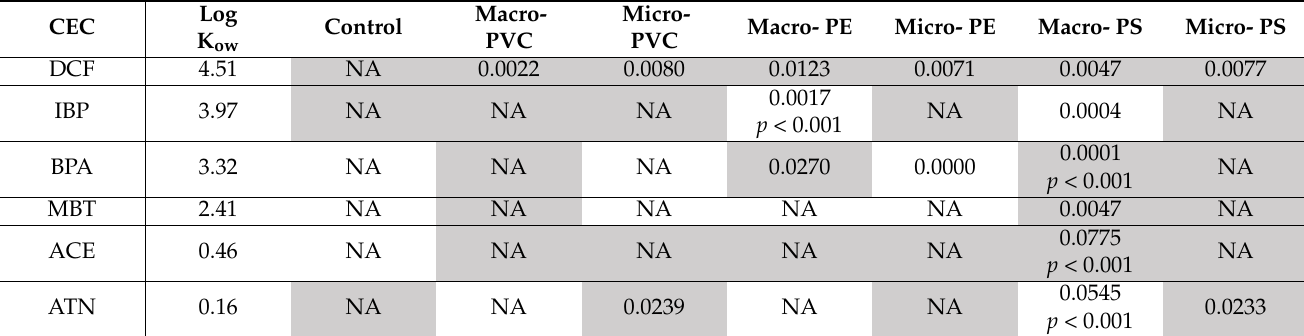
Table 1. The log K ow values (obtained from PubChem) and the pseudo-first order rate constant, k 1 (d − 1 ) for each of the CECs on the plastics. The significance of the rate constant is indicated by P using the chi-squared test. The CECs that were most likely sorbed onto the plastic are shaded in gray. Some CECs were retained on the plastic or control serum bottle glass immediately after exposure and did not have a rate constant associated with the sorption